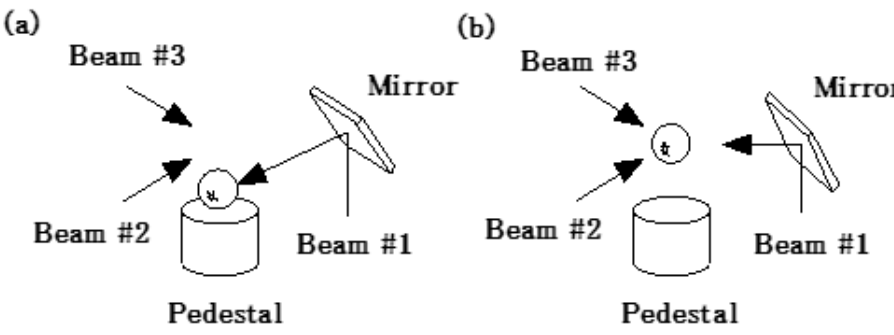
Figure 5. Schematic diagram of the launch initiation technique depicting the laser beam directions: ( a ) prior launching ( b ) during levitation [21].